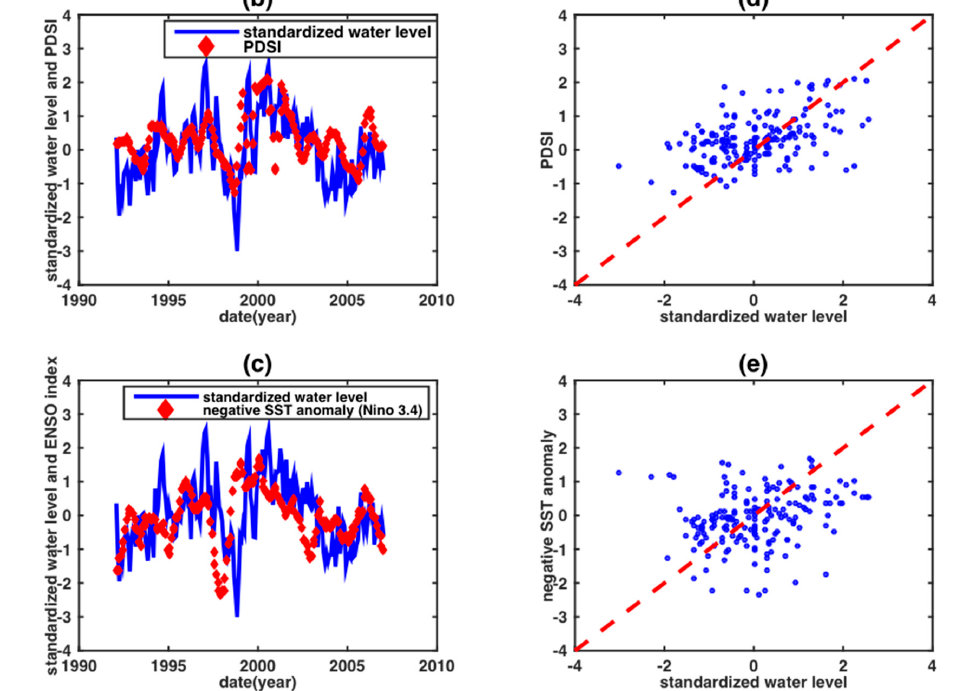
Figure 4. Time series of water levels in the Vam Kenh station arranged by year ( a ), and the water level anomaly in standardized form against the PDSI value ( b , d ) and negative SST anomaly value ( c , e ). The left side are the time series comparisons of PDSI and negative SST, and the right side are their scatter plots.